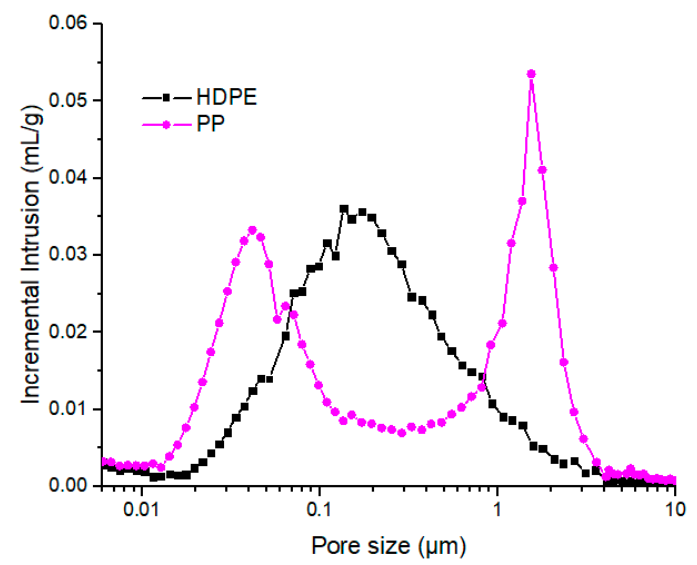
Figure7. Poresizedistributionafterwaxes(56wt%)solventextractioninHDPE / waxandPP / Figure 7. Pore size distribution after waxes (56 wt%) solvent extraction in HDPE/wax and PP/wax blends.